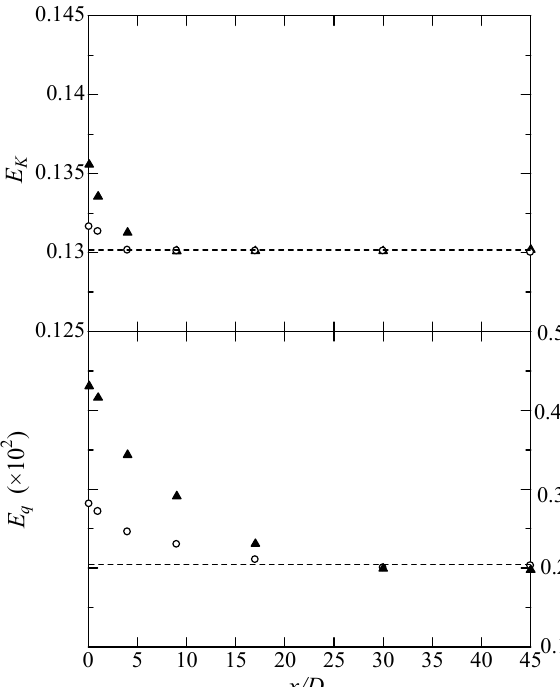
Fig. 10 Integral of mean kinetic and turbulent kinetic energy (same symbols as Fig.